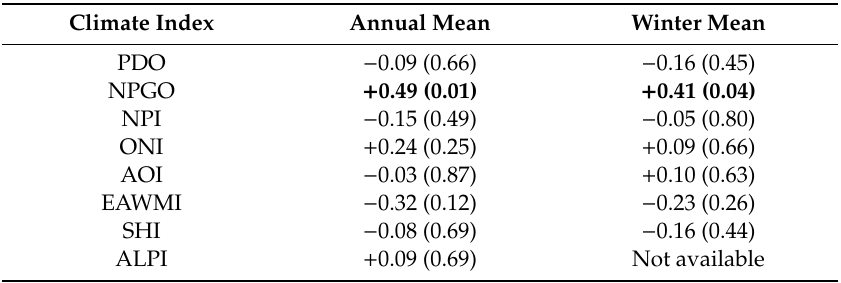
Table 2. Correlation coe ffi cients (and p -values) of annual mean and winter (ND) mean climate indices with the winter NEAMS-mean sea level anomaly. Values significant at the 95% confidence level are in